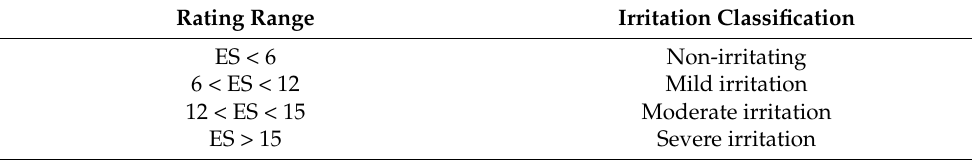
Table 1. ES Scoring